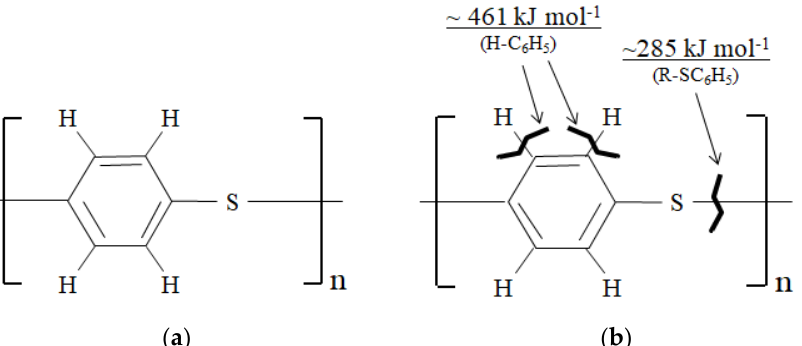
Figure 1. Constitutional formula of PPS: for untreated ( a ) and with reported bonding dissociation energies ( BDE ) [21,22] at dangling bond sites ( b ) . For ( b ) , ‘AR - ’ is the neighboring aromatic ring (-C 6 H 5 ) , where the ~285 [21] and ~461 kJ mol −1 [22] bonds are referred to here as “AR - S” and “AR - H”, respectively.